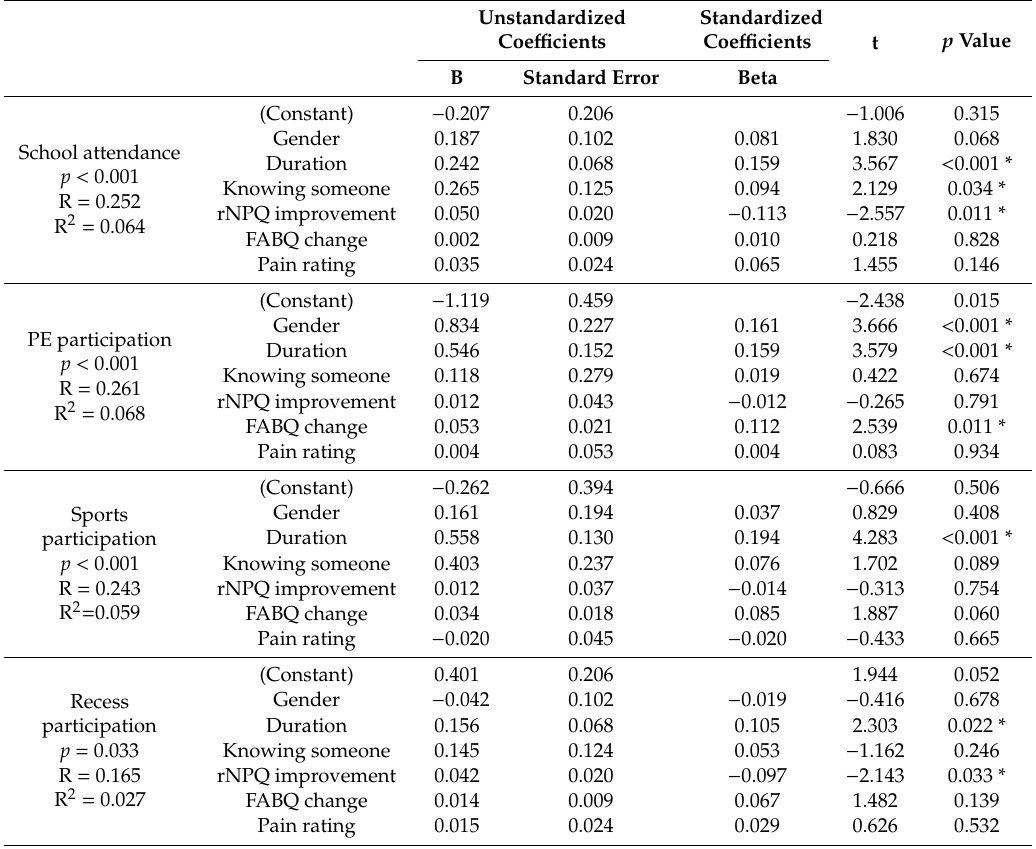
Table 4. Detailed findings for each of the regression analyses.